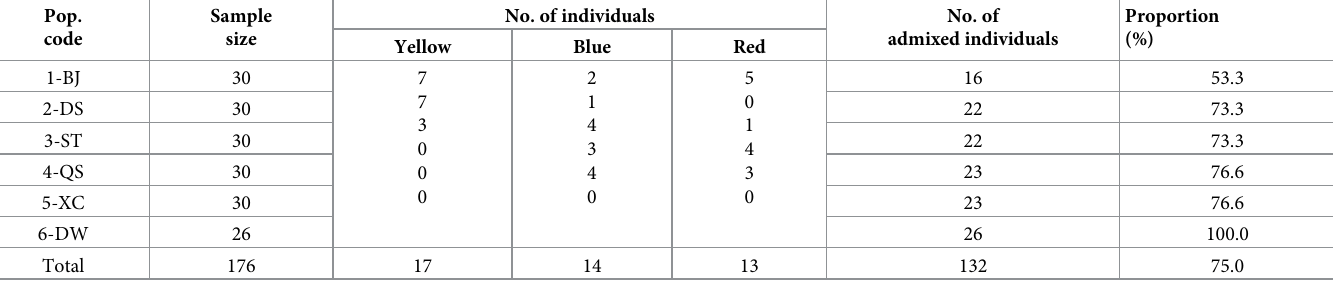
Table 3. Analysis of molecular variance (AMOVA) of the six Spartina alterniflora populations in Guangxi, China. Source df Est. Var. Among regions Among populations Within populations